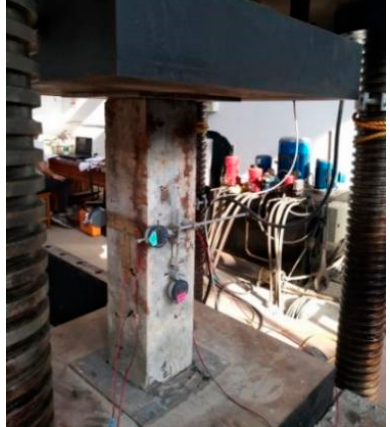
Appl. Sci. 2023 , 13 , x FOR PEER REVIEW